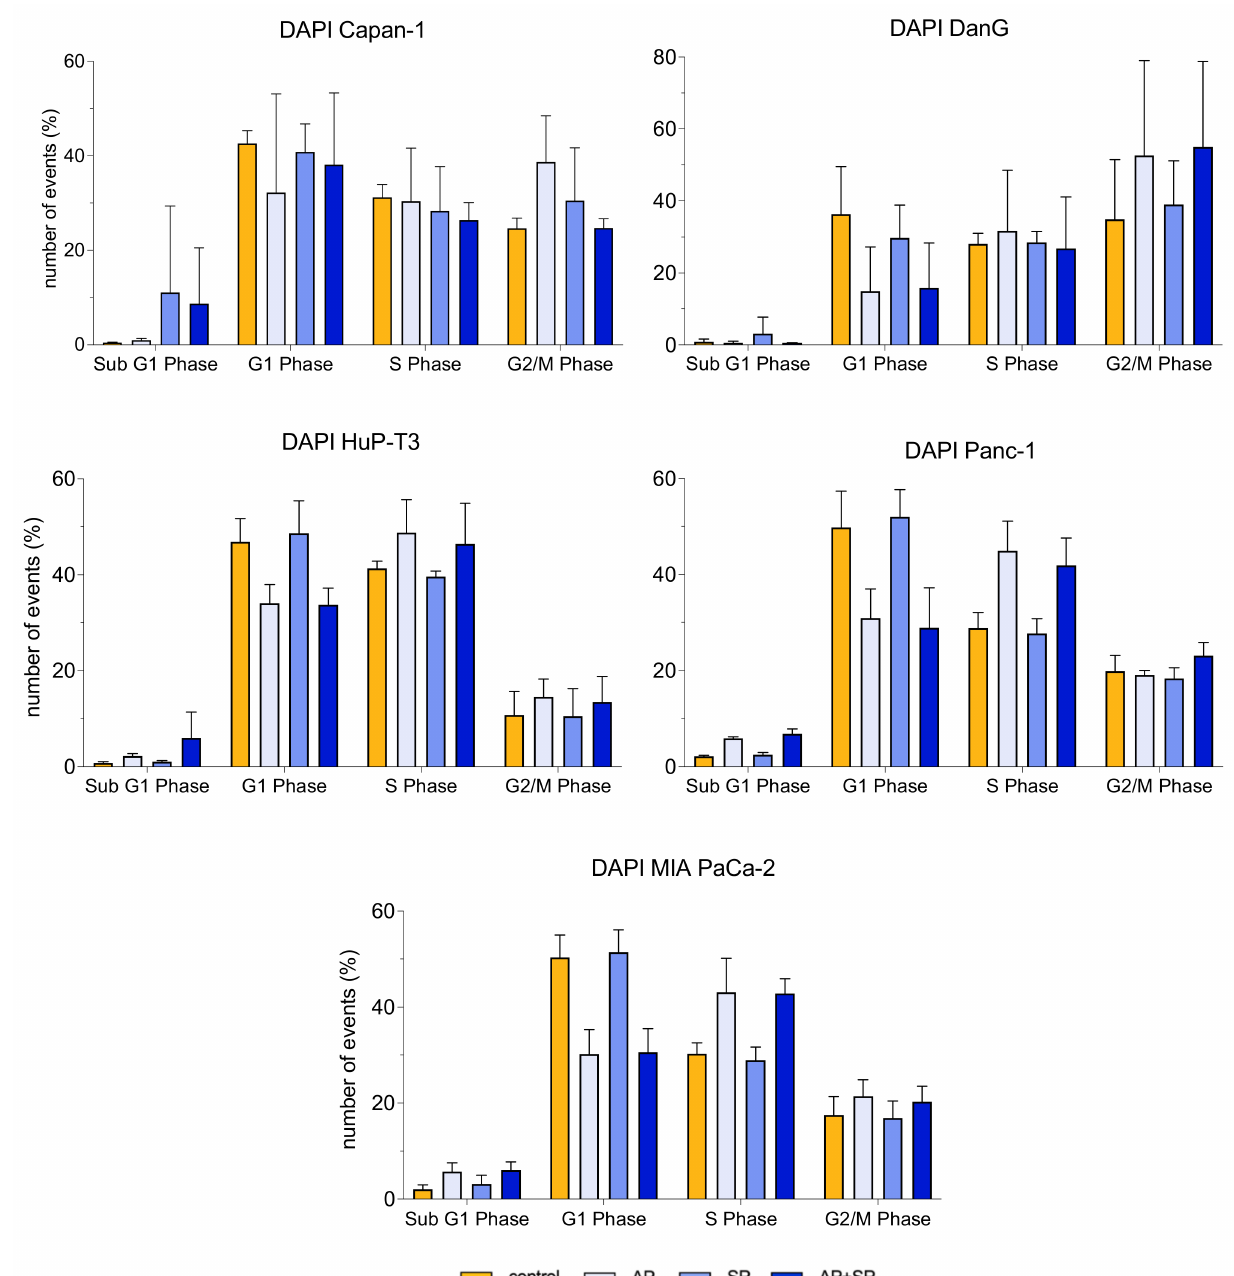
Figure A2. Bar Chart extension of Figure 5. DAPI staining results displayed in % for all cell cycle phases in the indicated cell